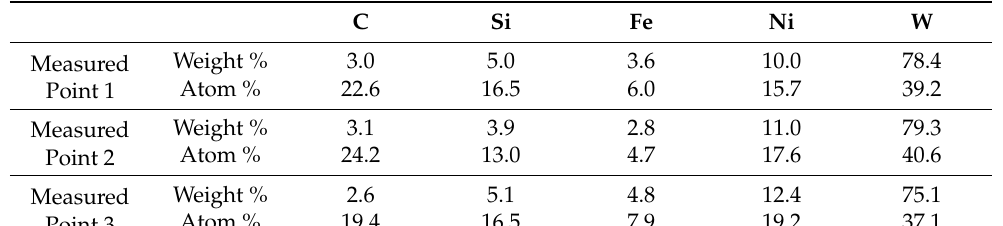
to microanalysis of sample 4-PE prepared under condition of 110 A PTA current and 1.5 L/min PGFR.